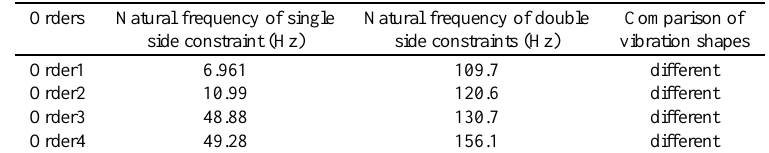
Table 6 The calculated modes of a panel with two kinds of boundary conditions